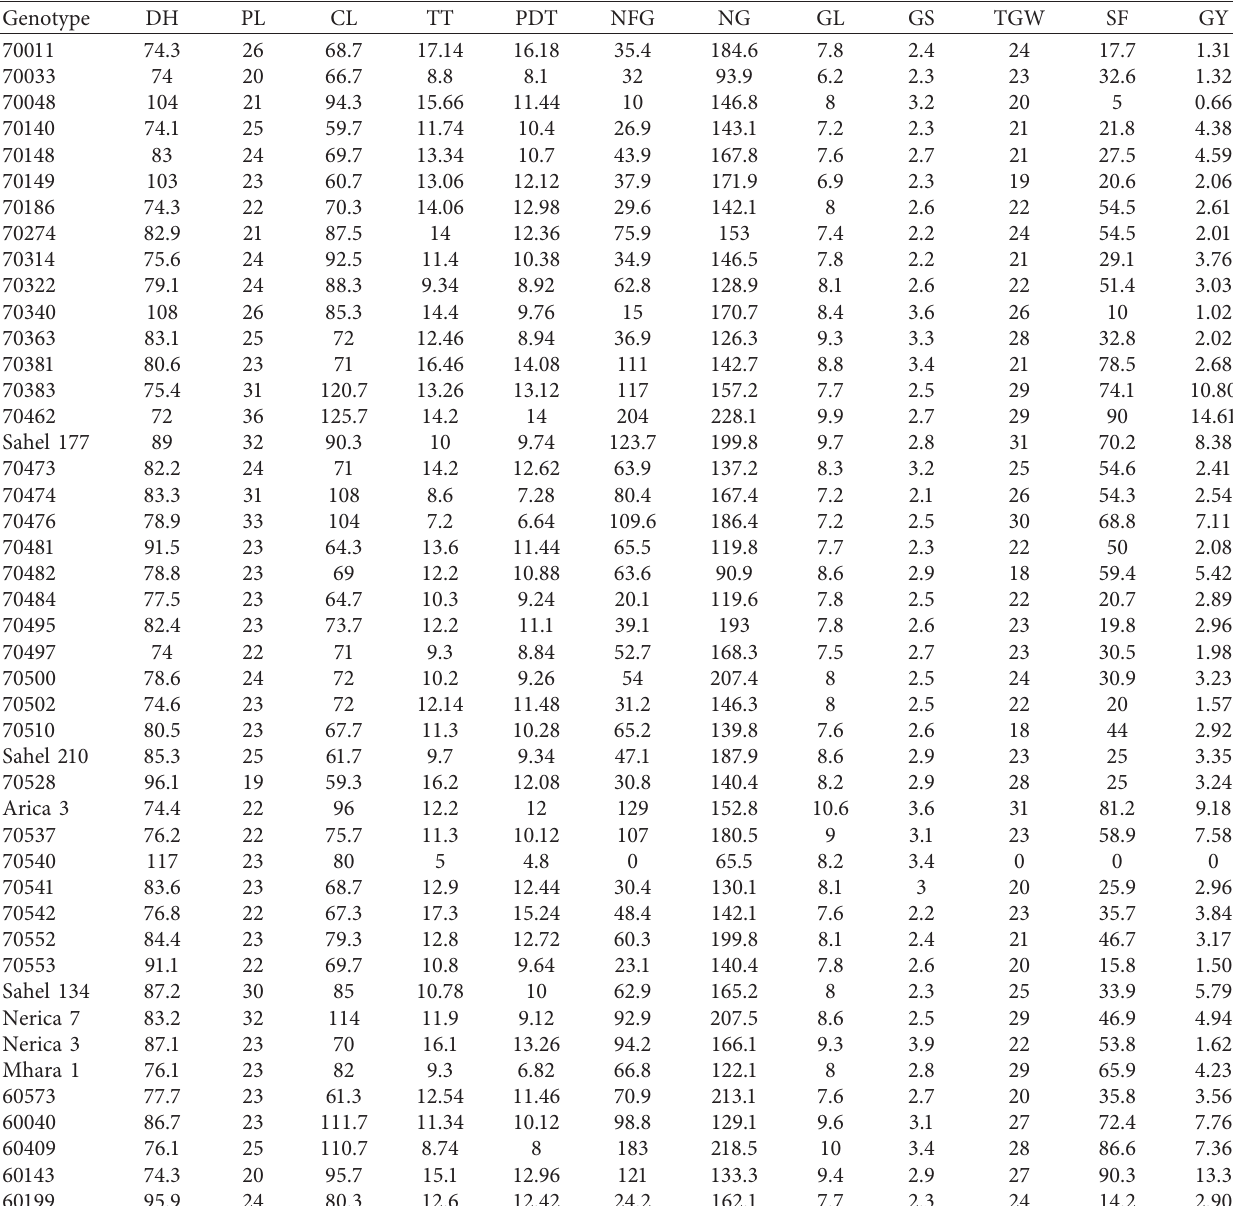
Table 5: Mean grain yield, yield components, and growth parameters of forty-nine rice genotypes under irrigated conditions.